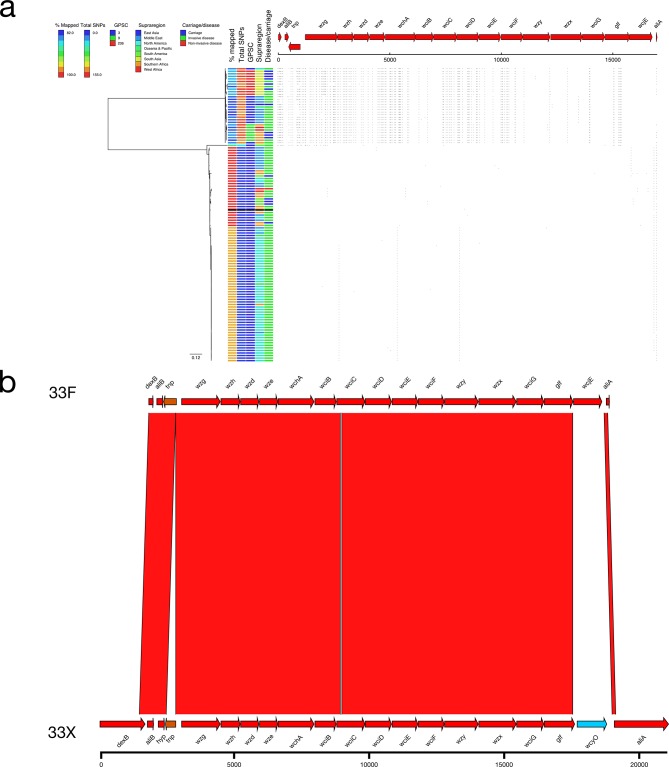
(a) Phylogeny and SNP map of serotype 33F. (b) Comparison of the putative serotype 33X sequence and the serotype 33F reference sequence.